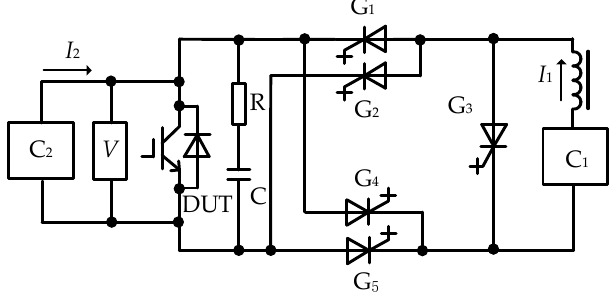
Figure 8. Schematic diagram of a bi-directional accelerated fatigue test.